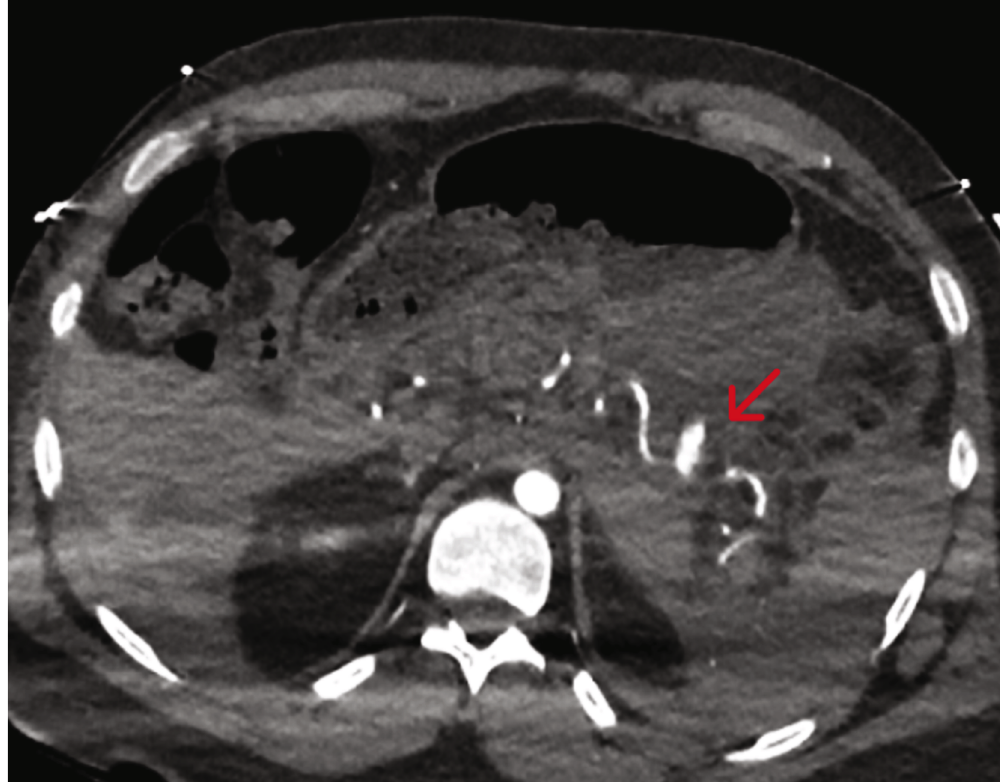
Figure 2: Splenic artery aneurysm with active contrast blush on abdominal CT